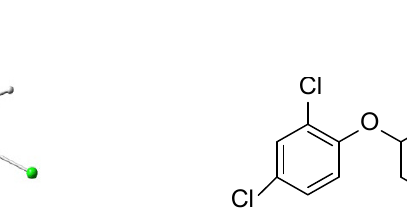
Fig. 1. Optimized structure of triclosan by B3LYP/6-311++G(2d,2p)